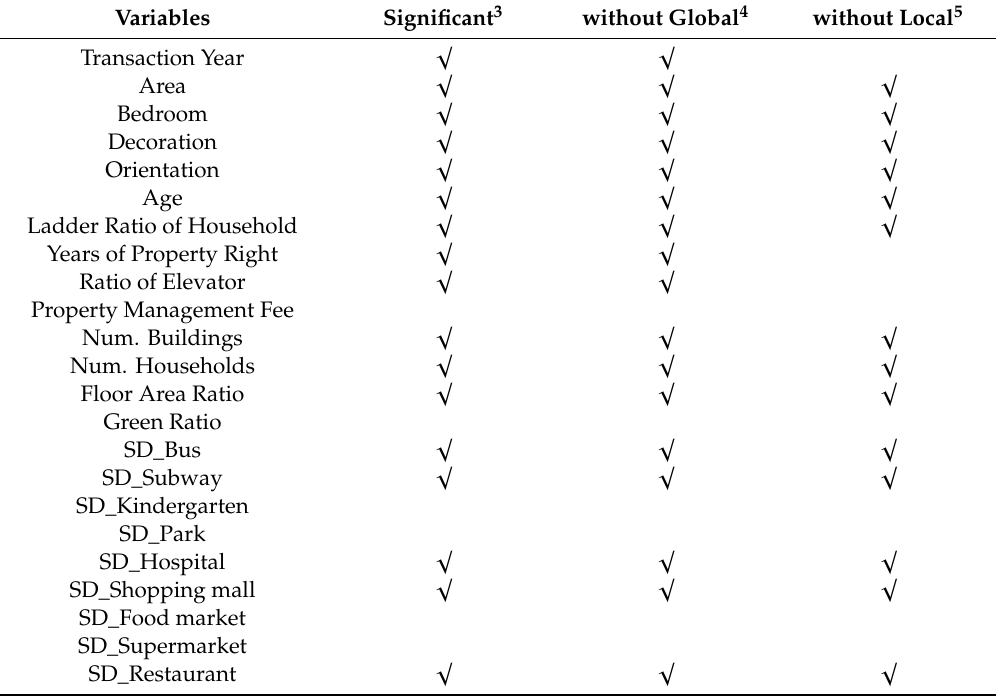
Table 4. Variables Selection.